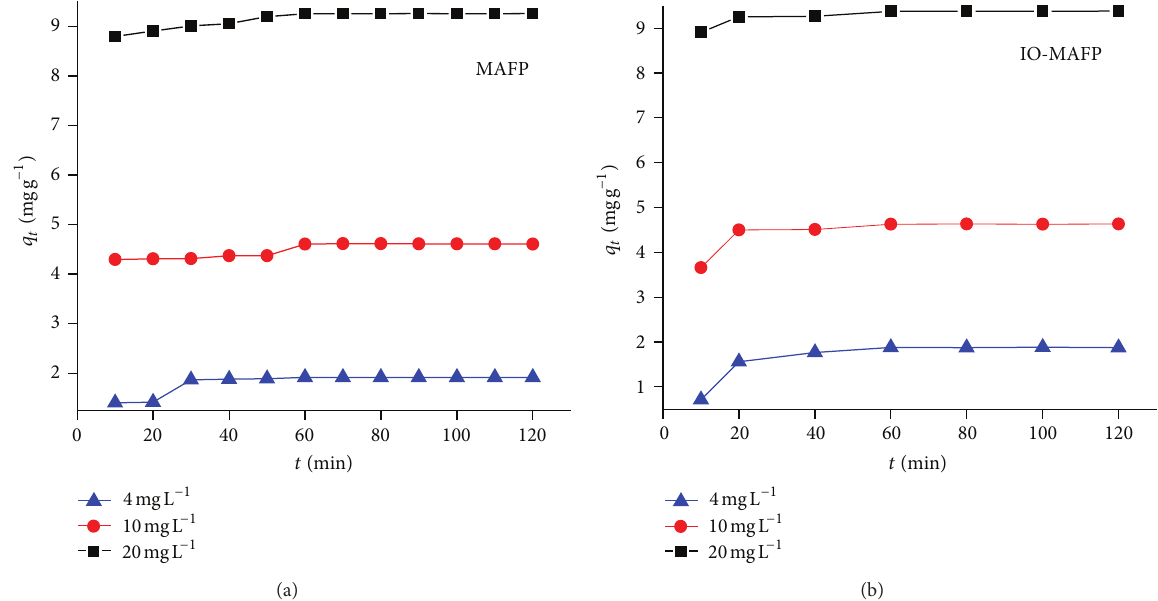
Figure 8: Effect of contact time and initial metal ion concentration on biosorption of Co(II) using MAFP and IO-MAFP biomasses.